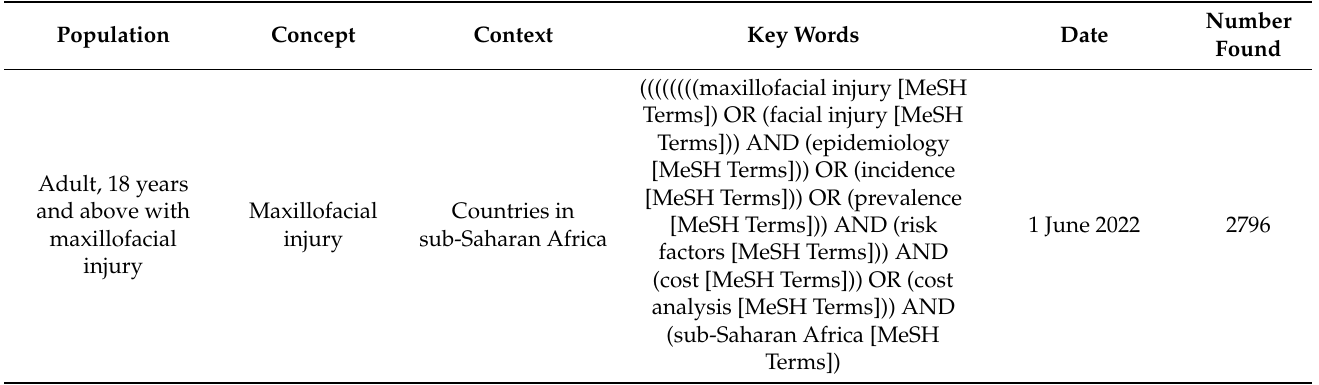
Table 2. Pilot search in PubMed electronic